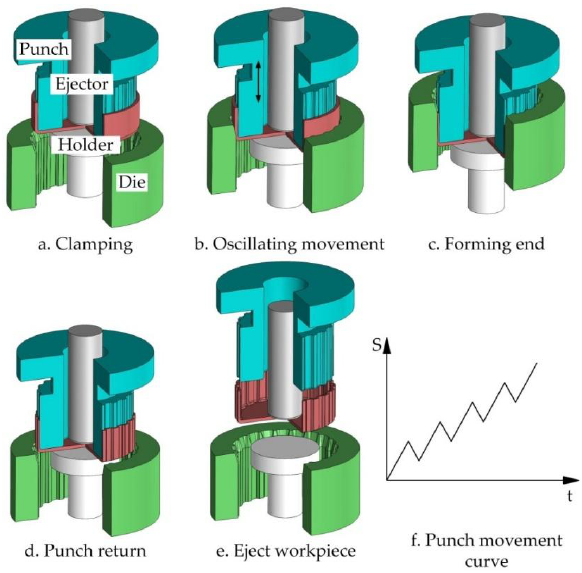
Figure 2. Procedure of clutch hub forming processing.